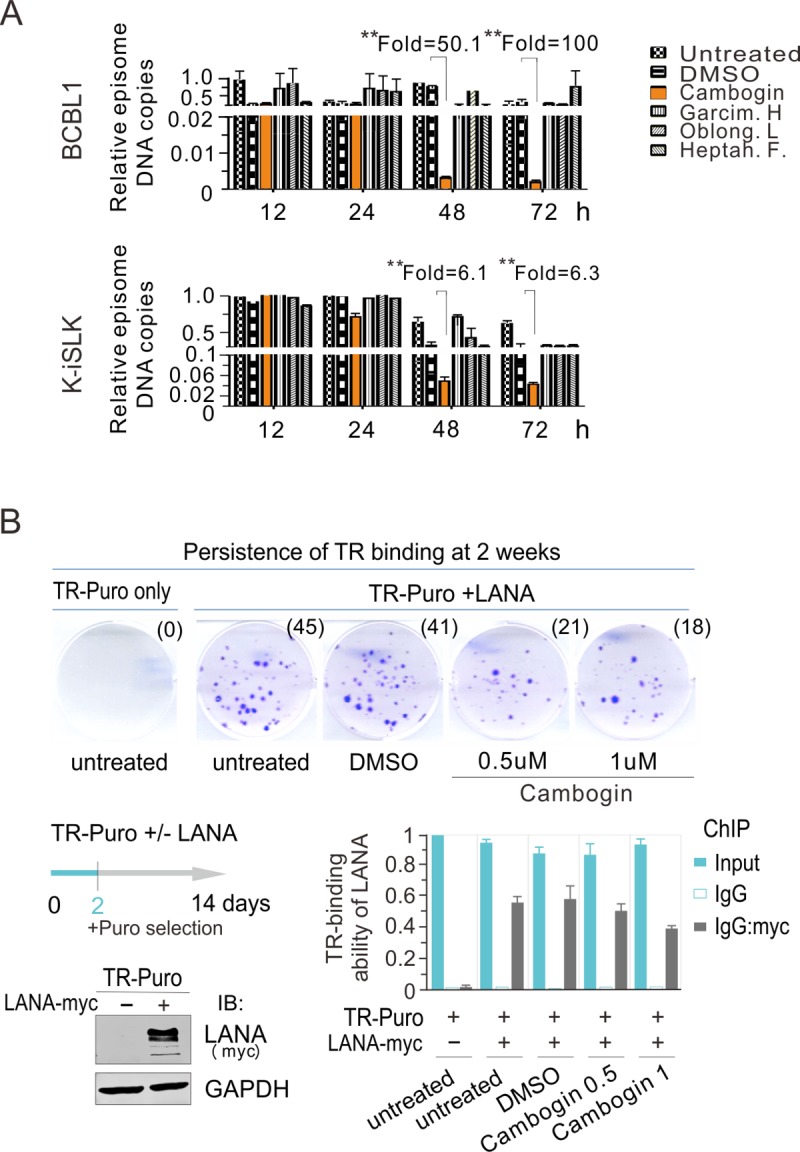
Cambogin blocks maintenance of KSHV episome DNA.(A) Equal amounts (0.2 million per ml) of KSHV-infected (BCBL-1, and K-iSLK) cells were individually treated with 100 nM Cambogin, Garcimultiflorone H, Oblongifolin L, Heptahydroxy Flavononylflavone, or DMSO as a control for the indicated time, and then harvested and subjected to quantitative PCR analysis to determine DNA copy number of the KSHV episome. The episome copy number relative to the untreated group was calculated and indicated in the figure. Asterisk indicates a significant difference (p<0.01). (B) Cambogin did not affect the TR-binding ability of LANA but inhibited the capacity of LANA-mediated TR maintenance. HEK293 cells co-transfected TR-puromycin plasmid with myc-tagged LANA or vector alone were equally divided and treated with different dosage of Cambogin or DMSO. At 48 h post-transfection, cells were subjected to ChIP assays with normal mouse IgG or mouse anti-myc (9E10) antibodies followed by real-time quantitative PCR with TR primer (bottom panels). For colony formation assays of LANA-mediated TR maintenance, three thousands transfected cells at 48 h post-transfection were seed and selected with 2 μg/ml puromycin cells for 2 weeks (Top panels). The average of colonies quantified from duplicate experiments is shown. The expression of exogenous LANA is presented by immunoblotting (IB) assay on the left panel.